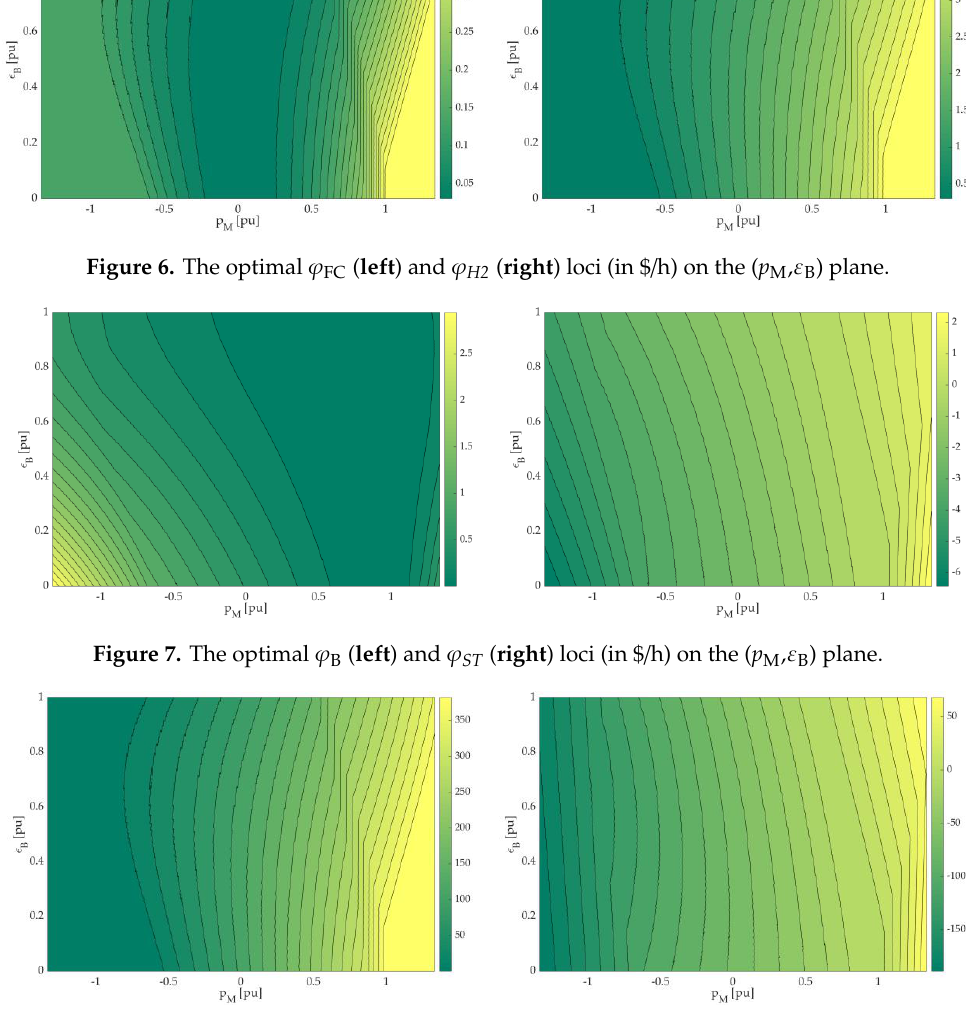
Figure 8. The optimal i FC ( left ) and i B ( right ) loci (in A) on the ( p M , ε B ) plane.